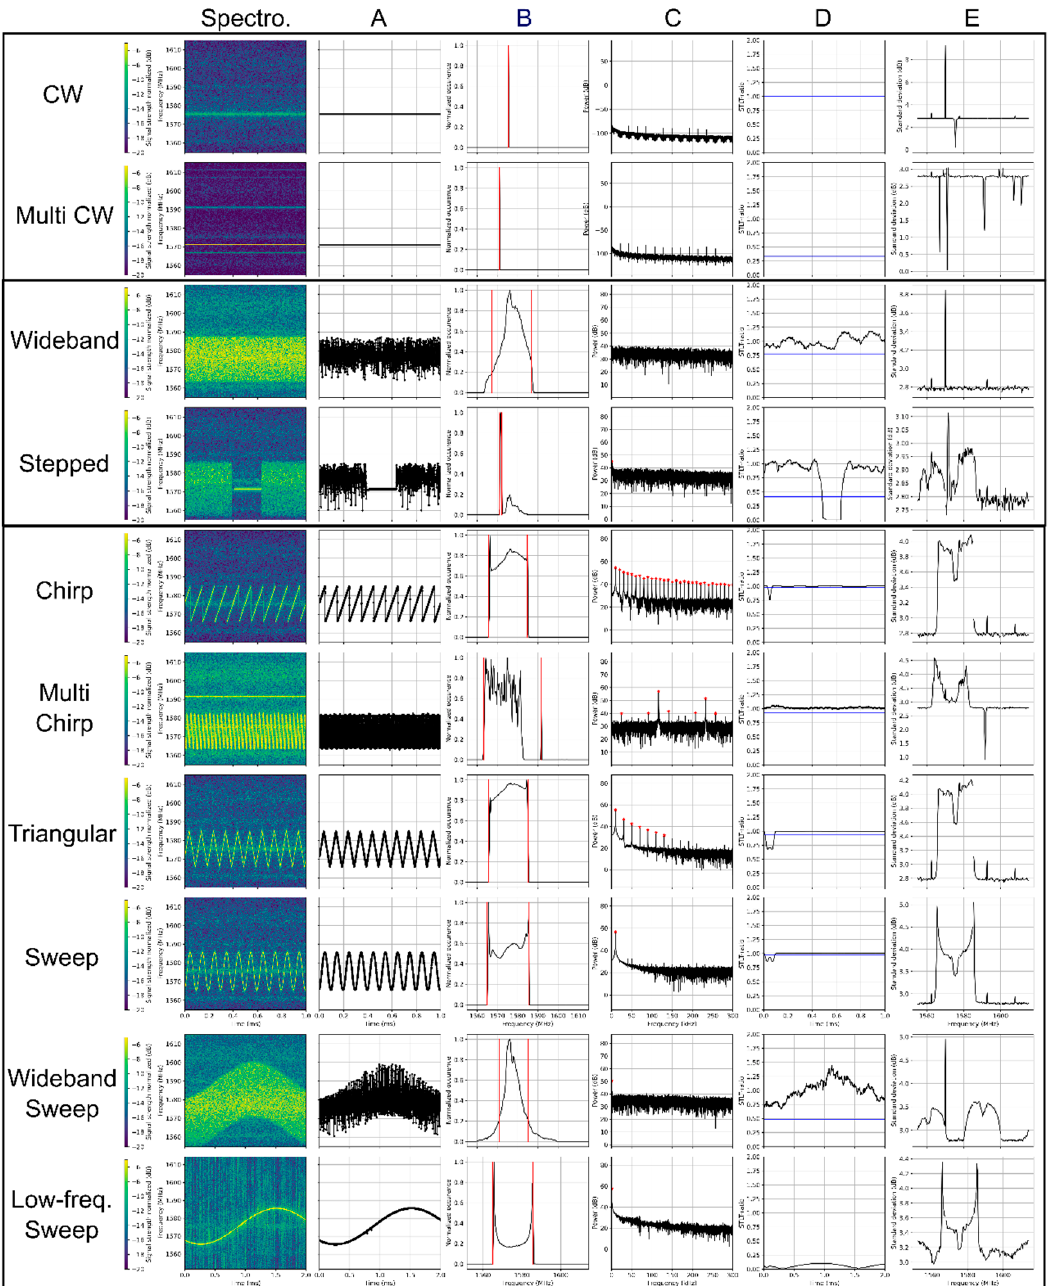
Figure 3. Overview over the identified RFI subcategories, their appearance in the spectrogram and the derived functions ( A – E ) for distinguishing the different classes (adapted from [15]).